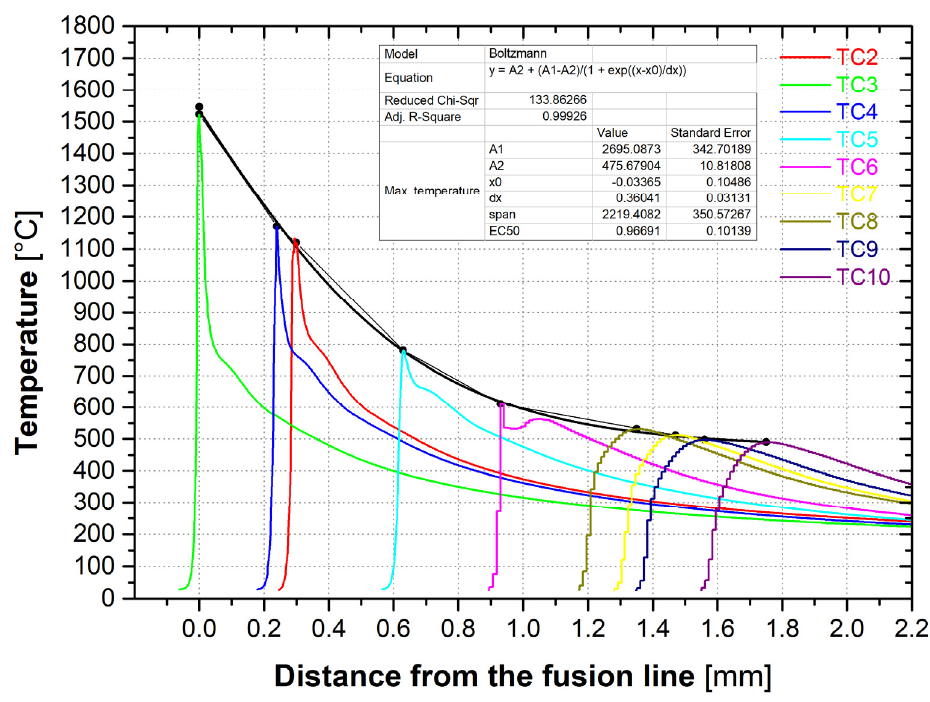
Figure 13. Mathematical description defining the temperature distribution in HAZ for weld with a heat input value 14 kJ·cm − 1 .